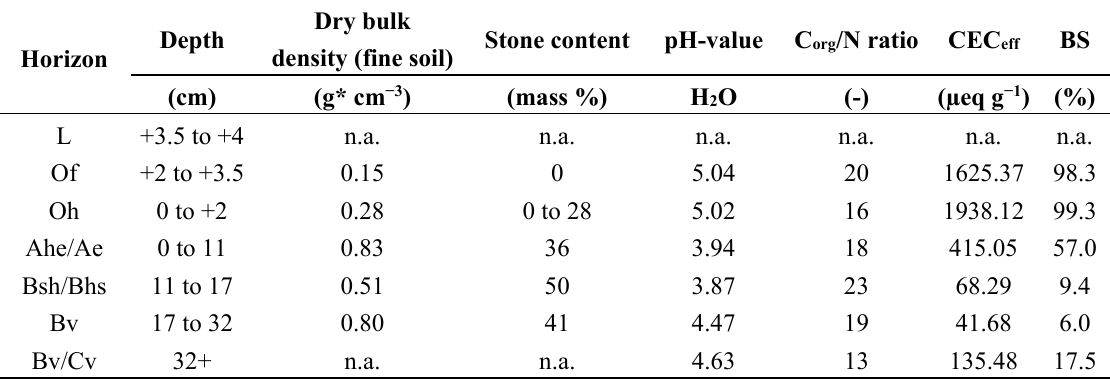
Table 2. Description of the soil physical and chemical properties for the study site (samples came from an extra soil profile created for the characterisation of the study site), n.a. = not